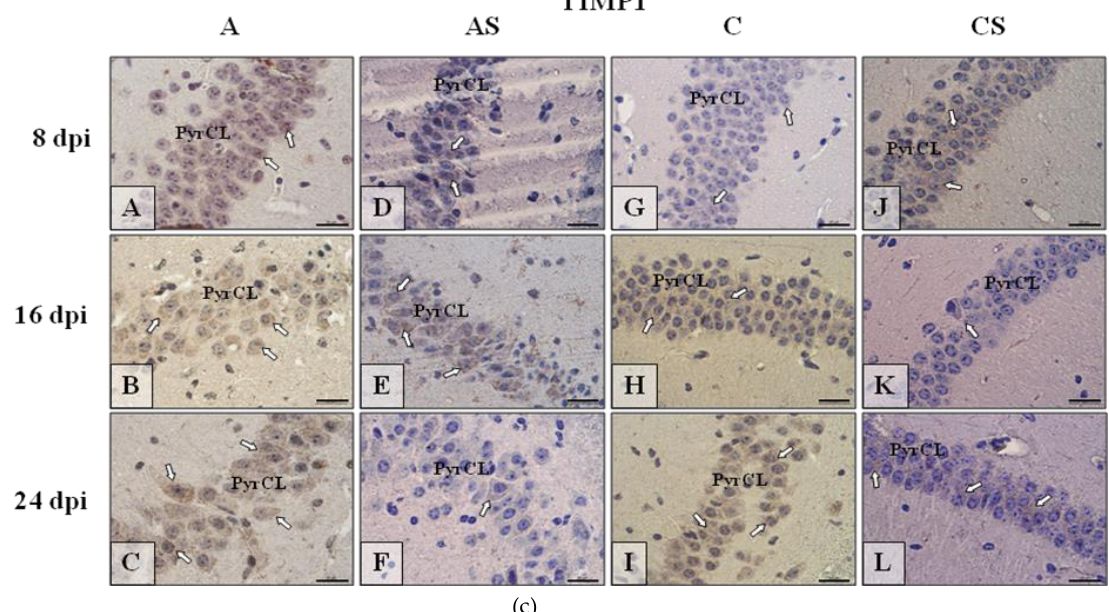
Figure 7. ( a ) Representative microphotography showing immunoexpression (brown color) of tissue inhibitors of metalloproteinase-1 (TIMP-1) in the neocortex of mice from control group (a, G–I), immunosuppressed uninfected control group (a, J–L), immunocompetent infected by Acanthamoeba spp. (a, A–C) and immunosuppressed Acanthamoeba spp. infected group (a, D–F) in 8, 16, and 24 day post infection (dpi). White arrows show immunoexpression of TIMP-1 in neurons of cerebral cortex. ( b ) Representative microphotography showing immunoexpression (brown color) of TIMP-1 in neurons of granular cell layer (GCL) of the gyrus dentatus of mice from control group (b, G–I), immunosuppressed uninfected control group (b, J–L), immunocompetent infected by Acanthamoeba spp. (b A–C) and immunosuppressed Acanthamoeba spp. infected group (b, D–F) in 8, 16, and 24 dpi. White arrows show immunoexpression of TIMP-1 in neurons of GCL of hippocampus, black arrows show immunoreactivity of big neurons of polymorphic cell layer. White asterisk (b, D) shows tendency to immunolocalization of TIMP-1 in basal region of GCL. ( c ) Representative microphotography showing immunoexpression (brown color) of TIMP-1 in neurons of pyramidal cell layer (PyrCL) of the cornu ammonis of mice from control group (c, G–I), immunosuppressed uninfected control group (c, J–L), immunocompetent infected by Acanthamoeba spp. (c, A–C) and immunosuppressed Acanthamoeba spp. infected group (c, D–F) in 8, 16, and 24 dpi. White arrows show immunoexpression of TIMP-1 in neurons of that region of hippocampus. Objective magnification a – c : ×100. Scale bar = 20μm.